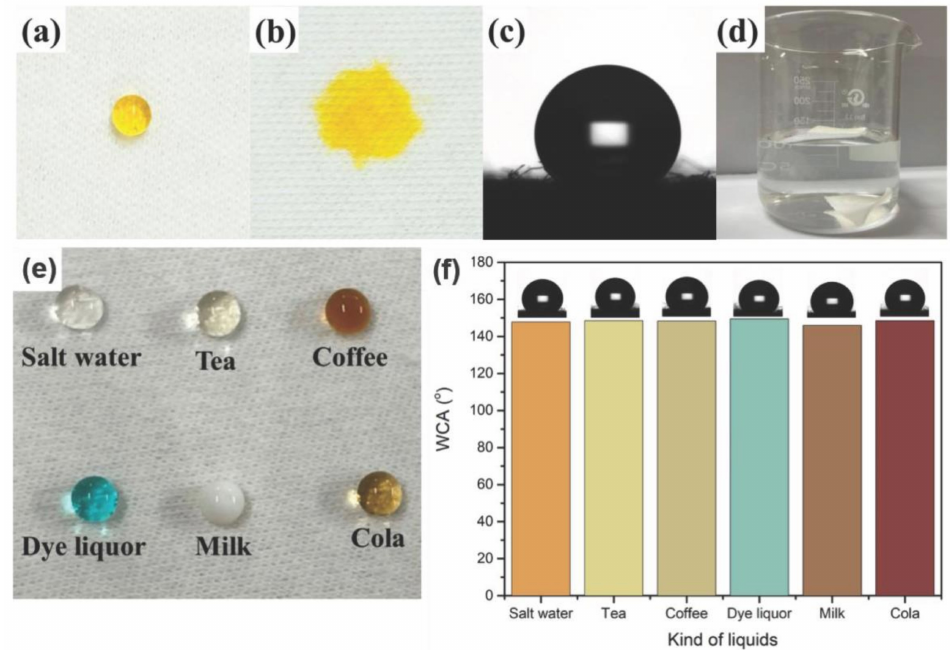
Figure 3. The images of a dye droplet on the finished ( a ) and unfinished ( b ) cotton fabric; WCA of the finished cotton fabric ( c ); finished and unfinished cotton fabric in water ( d ); a variety of common liquids standing on the finished cotton fabric ( e ); WCA value of different droplets on the finished cotton fabric ( f